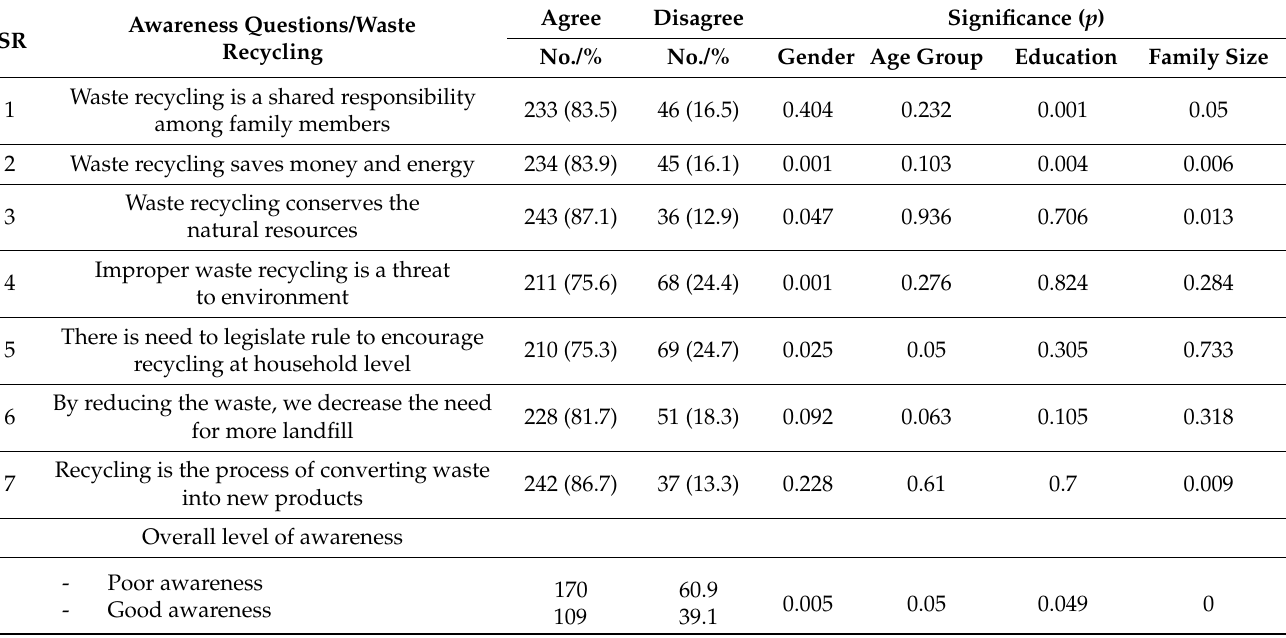
Table 3. Awareness of the households regarding waste recycling ( n = 279).